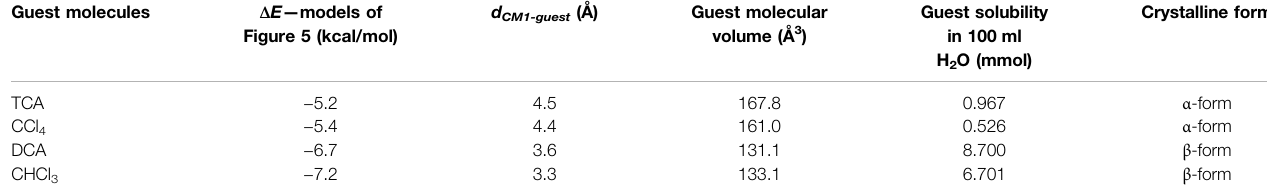
TABLE4| ValuesoftherelevantparametersthatcontroltheformationoftheCCandNC α -and β -formsofPPO,deducedfromcalculations( Δ E and d CM1-guest )andempirical correlations (molecular volume and water solubility) of DCA and CHCl 3 as examples of β guest inducers and TCA and CCl 4 as an example of α guest inducers. Guest molecules